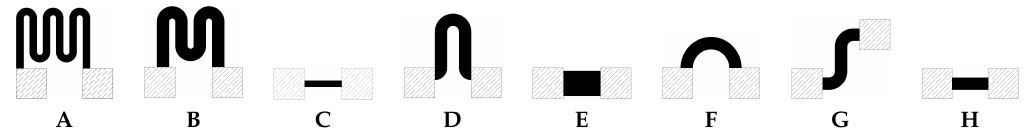
Figure 2. Carbon resistors test geometries. Carbon ink coverage on black. Dashed regions represent the overlap of carbon ink and silver ink for connection. Labels from A to H for further reference in Table